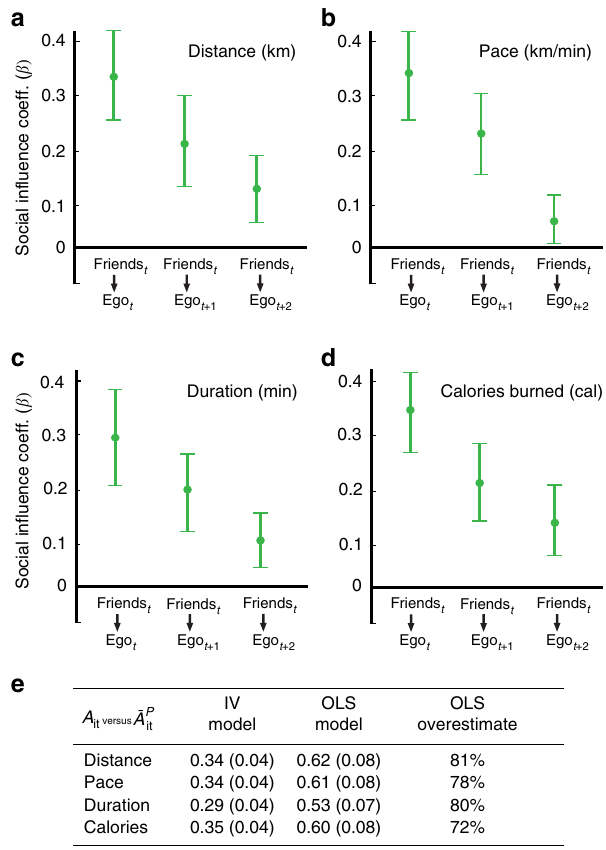
Figure 1 | Peer effects in global running behaviours. The panels display social influence coefficients from second-stage regressions in the two-stage least squares specification for friends’ behaviour at time t influencing ego at time t , t þ 1 and t þ 2 for ( a ) distance ran in kilometres (km), ( b ) pace in km per minute, ( c ) running duration in minutes and ( d ) calories burned. Bars are 95% confidence intervals. ( e ) The table at the bottom of the figure compares social influence coefficients and s.e. from the IV models to those from the OLS models and provides the OLS overestimates of social influence as a percentage of the IV